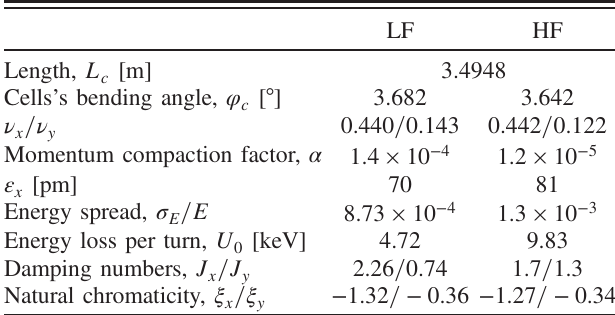
TABLE III. Parameters of SKIF LF and HF